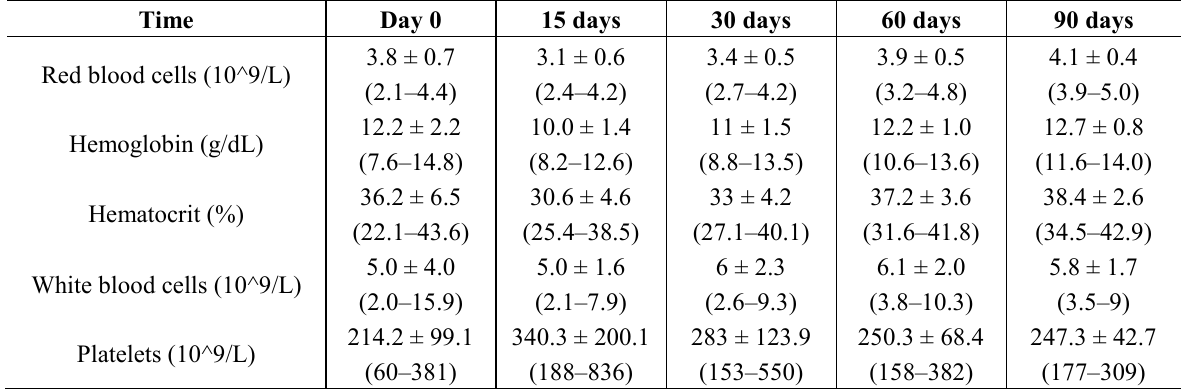
Table 3. Hematological parameters and biochemical values of 10 anorexia nervosa patients, monitored frequently during refeeding treatments a